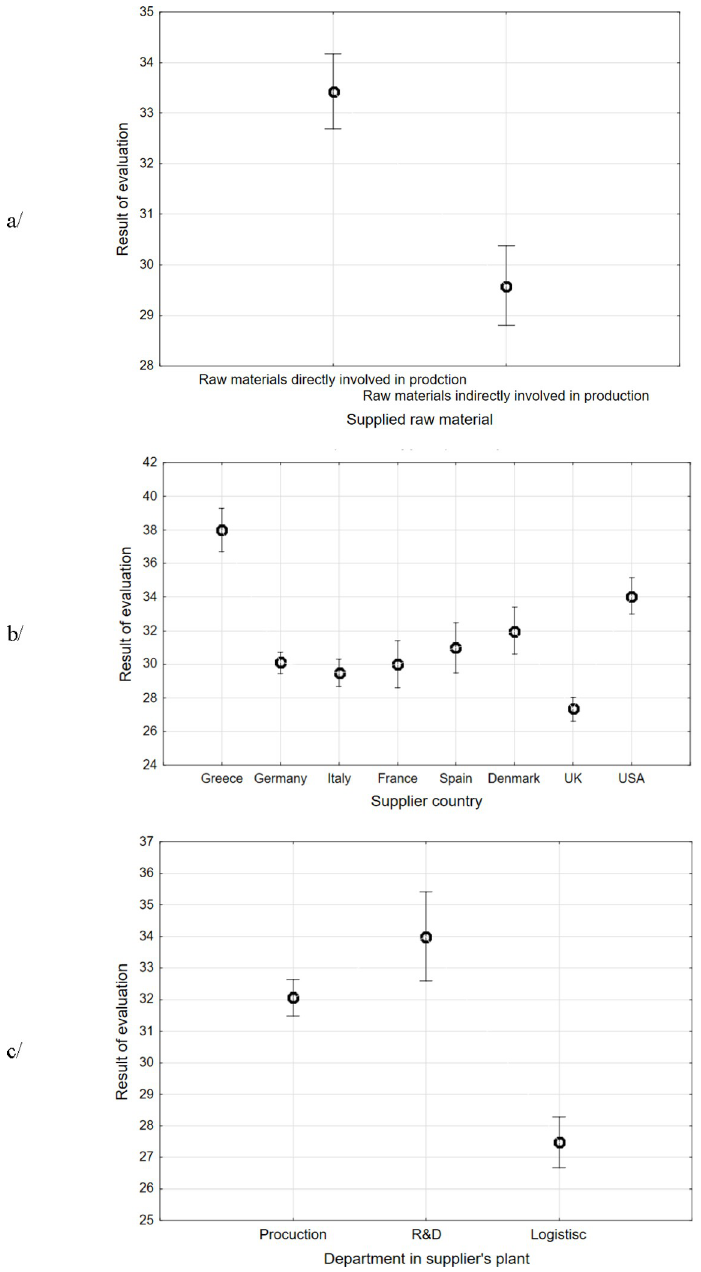
Fig 2. Influence of the information about suppliers on evaluation results: a) type of raw materials supplied, b) supplier location, c) department where the raw materials were